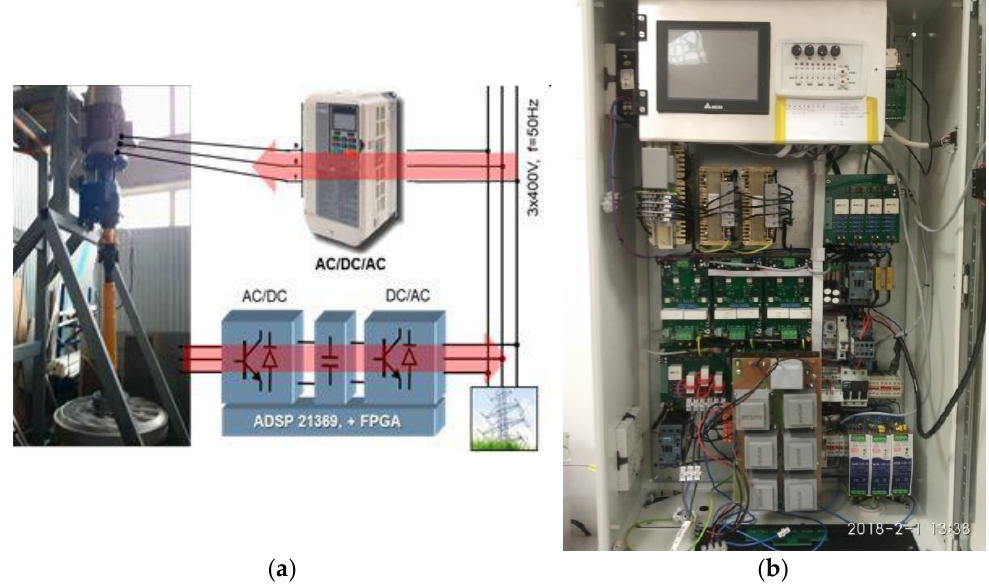
Figure 5. Photographs of the laboratory stand: ( a ) generator drive with drive motor and its power supply and ( b ) converters (topology T1 and T2) with the control panel.